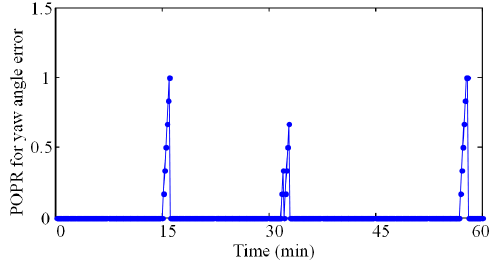
Figure 19. POPR for yaw angle error.